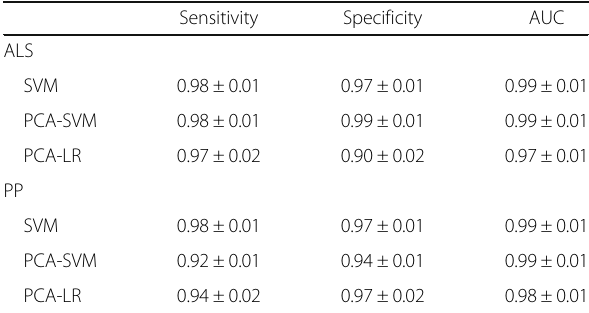
Table 2 Performance measures for classification between ALS versus HC and PP versus HC for SVM, PCA-SVM, and PCA-LR: sensitivity, specificity, and AUC